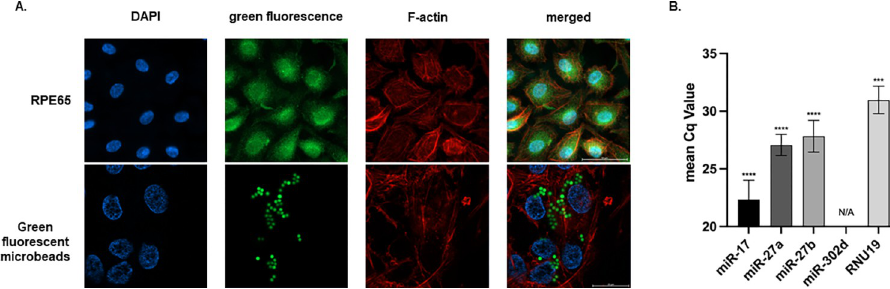
Fig 1. Identification of hRPE cells and miR-302d expression. (A) hRPE cells were immunostained for RPE65 and green fluorescent microbeads. The scale bar represents 50 μ m for RPE65 and 20 μ m for microbeads. (B) Mean Cq values of miR-17, miR-27a, miR-27b, miR-302d, and RNU19 of TaqMan 1 MicroRNA assay. Cq values > 35 were classified as not available. One-sample t-tests (n = 3) were performed to detect differences between mean Cq values and 35. The error bars represent SD. N/A, not available, ��� p < 0.001, ���� p < 0.0001.